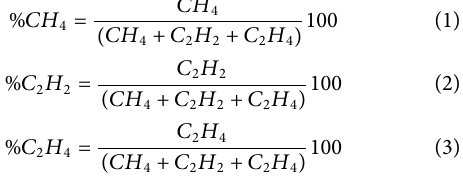
The Duval triangle 1 method employs three fault gases that depends on temperature rise in case of fault. Duval triangle